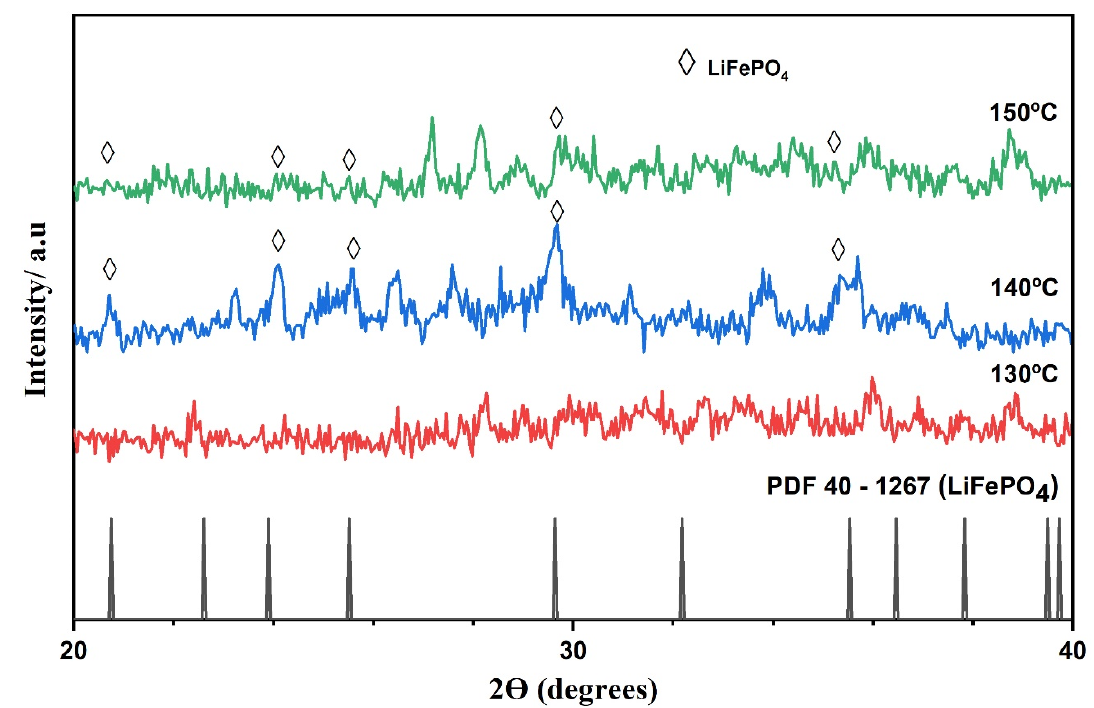
Figure 5. XRD patterns of the LiFePO 4 particles obtained by hydrothermal synthesis at 130, 140 and 150 °C.